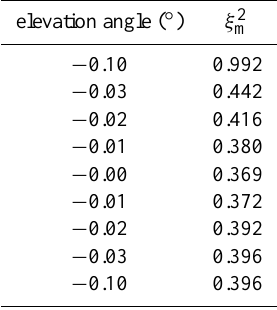
Table 4. Fit of measurements for cross-section retrievals with different fixed elevation angle